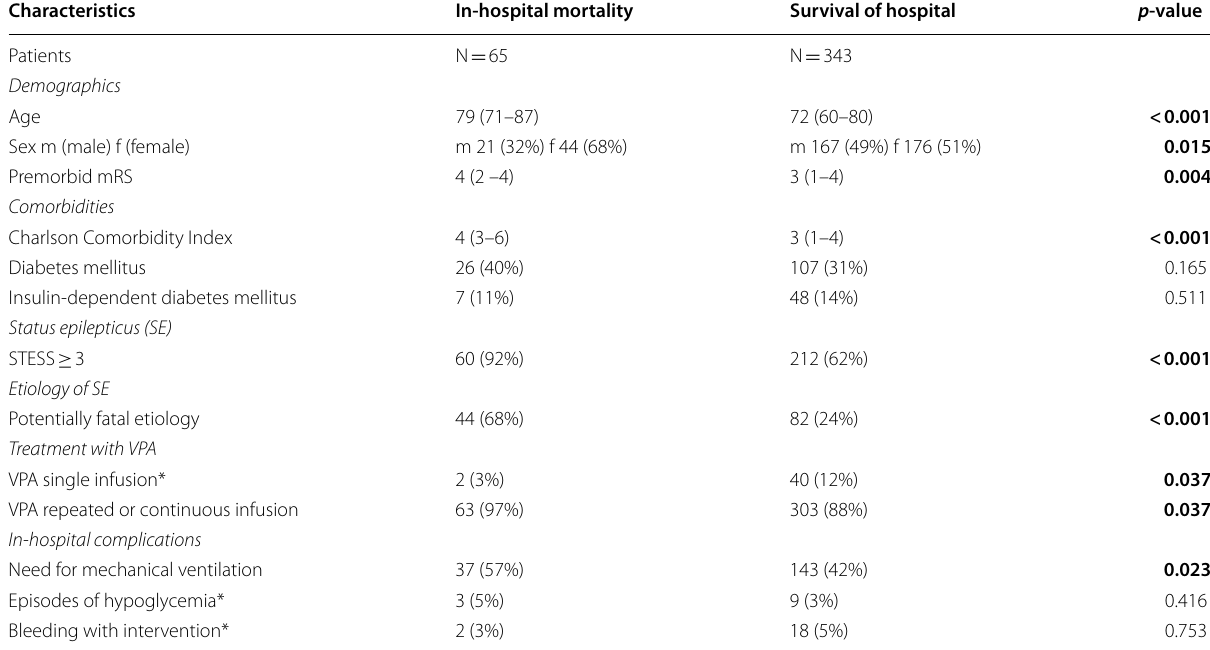
Metric variables are described with median and interquartile range, categorial variables in number and percentage. Continuous variables were compared using Mann–Whitney U test. Proportions were compared using Pearson´s Chi2 test or Fisher´s exact test (*). Statistically significant values ( p < 0.05) are expressed in bold mRS modified Rankin scale; STESS status epilepticus severity score; SE status epilepticus; VPA valproic acid